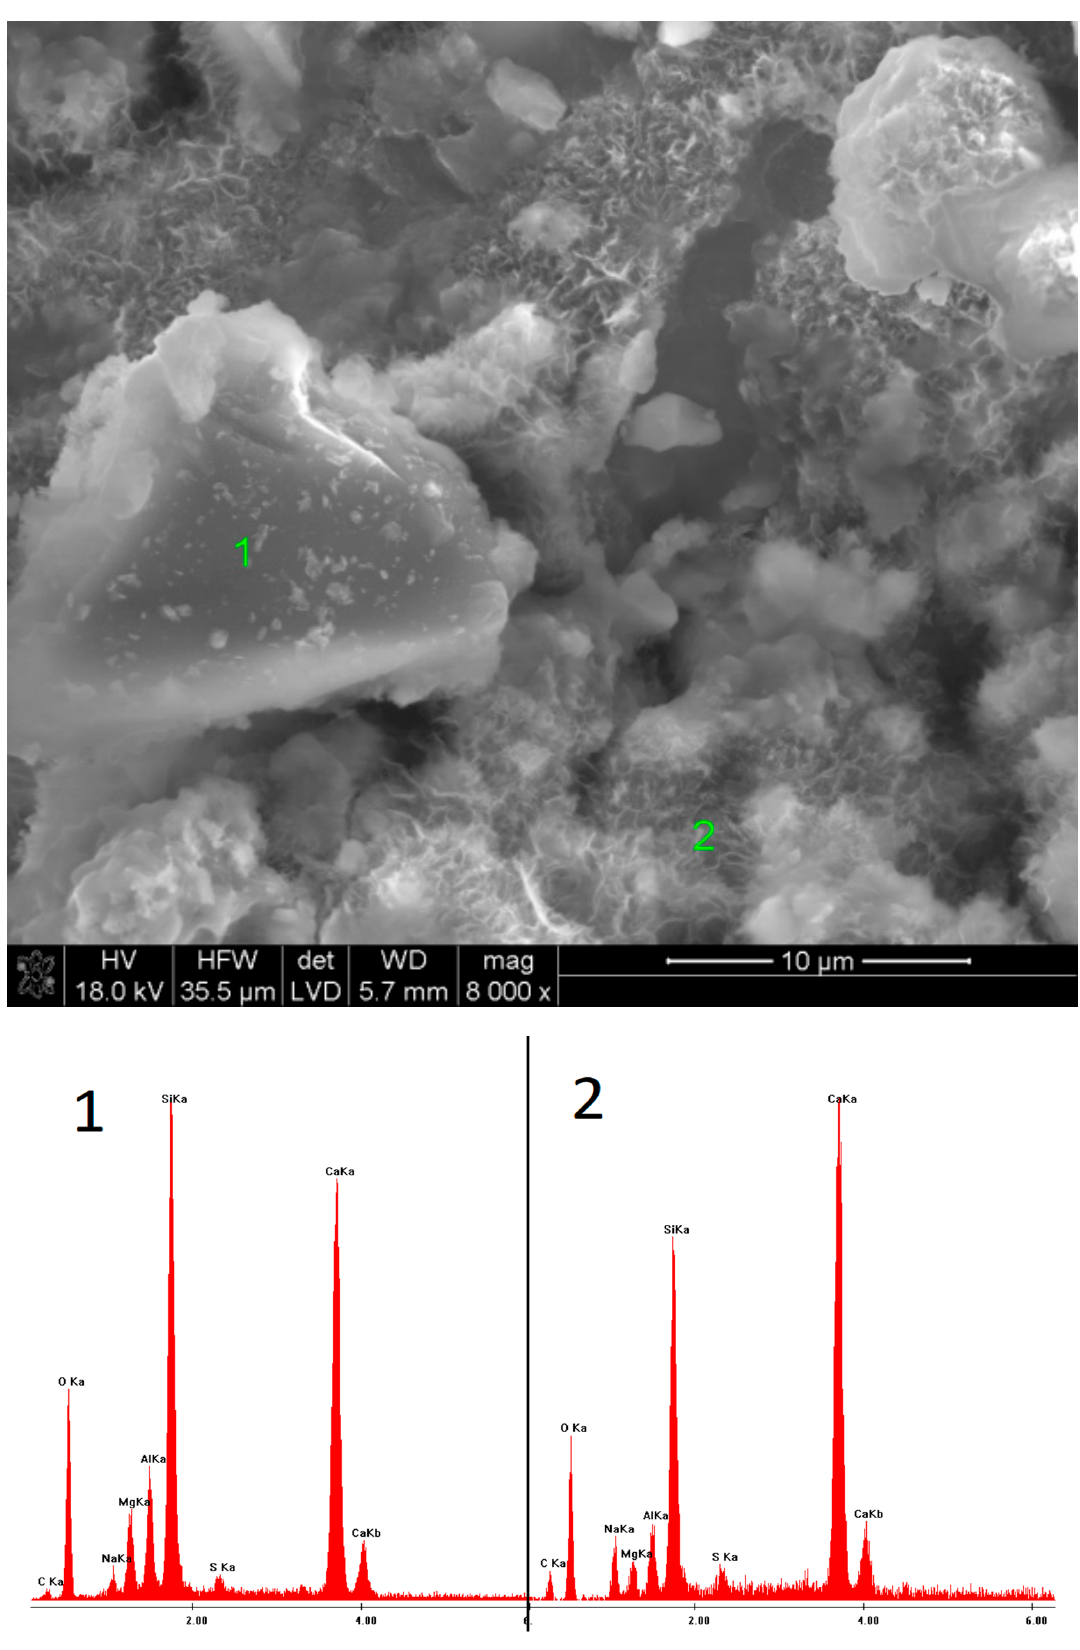
Figure 17. Microstructure of slag paste activated with sodium formate after 40 days of curing—SEM + EDS; 1 —slag grain; 2 —hydration products.